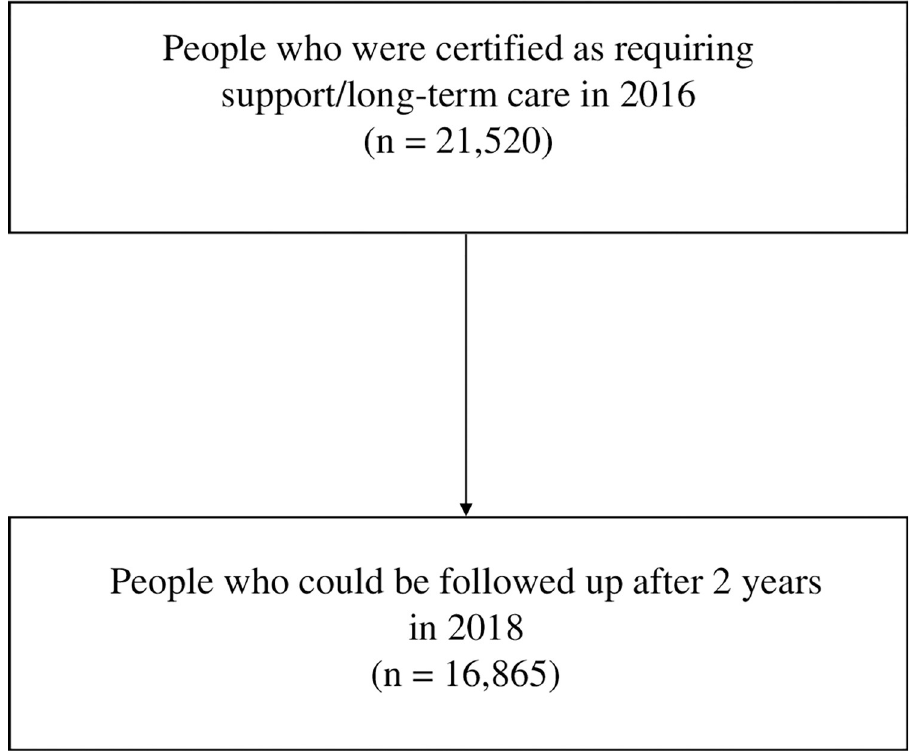
Fig 1. Flowchart of participant